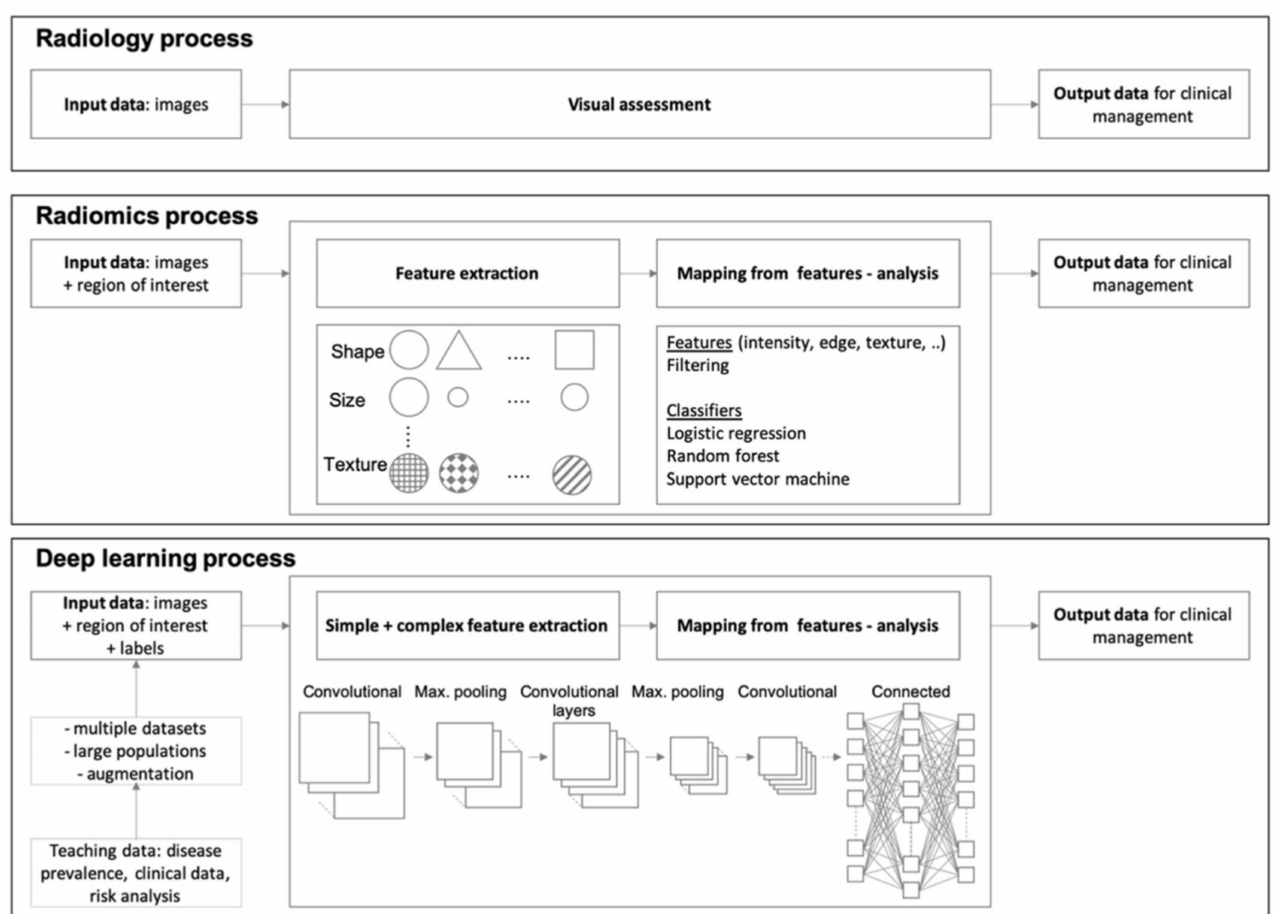
Figure 4. Workflow of standard radiology reporting compared to AI-based methods of radiomic and DL. The entire complexity of deep learning is only schematically shown. There is an abundance of different network architectures or CNN which are beyond the scope of this study. This figure only demonstrates a schematic CNN (reprinted under common creative license 4.0 from [44], Copyright 2021 Springer